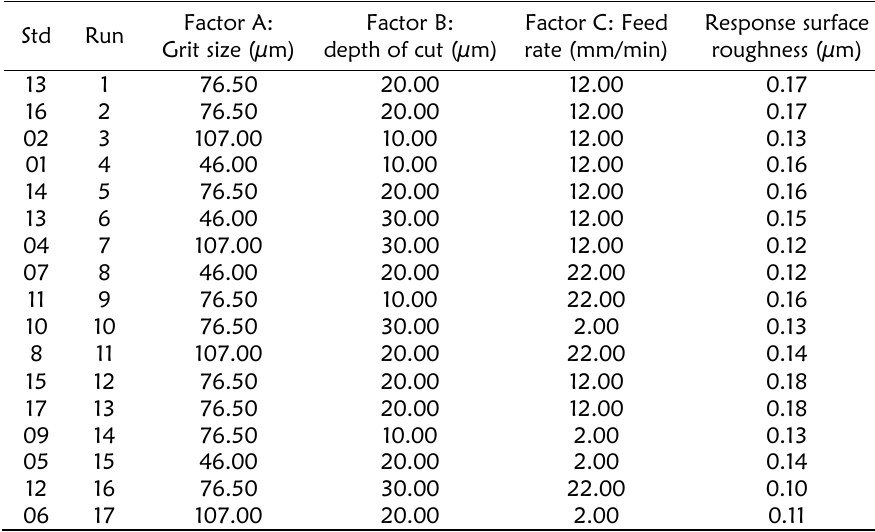
Table 2: Box-Behnken designs showing trial runs and response variable R a .